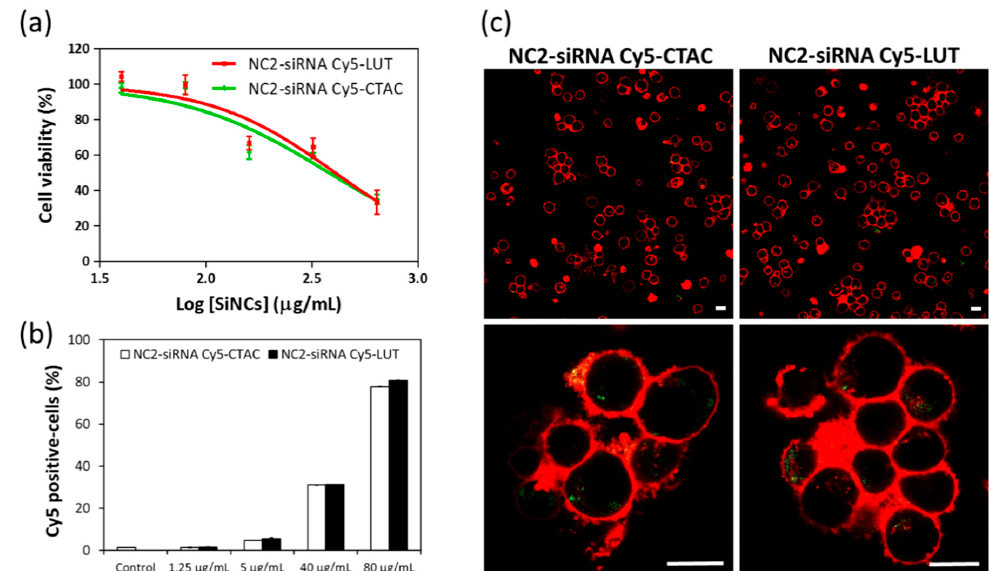
Figure 2. Cellular uptake study of SiNCs encapsulated siRNA Cy5 in CD8 + T-cells. ( a ) Cell viability, ( b ) Cy5 positive-cells, and ( c ) cLSM images of CD8 + T-cells, after treatment with SiNCs encapsulated siRNA Cy5 for 17 h. The membrane was stained with CellMask™Orange (red). The SiNC was labeled with Oligo Cy5 (green). The scale bars represent 10 µm. The EC 50 of NC2-siRNA Cy5-CTAC and –LUT were 380 and 406 µg/mL, respectively. The scale bars represent 10 µm.